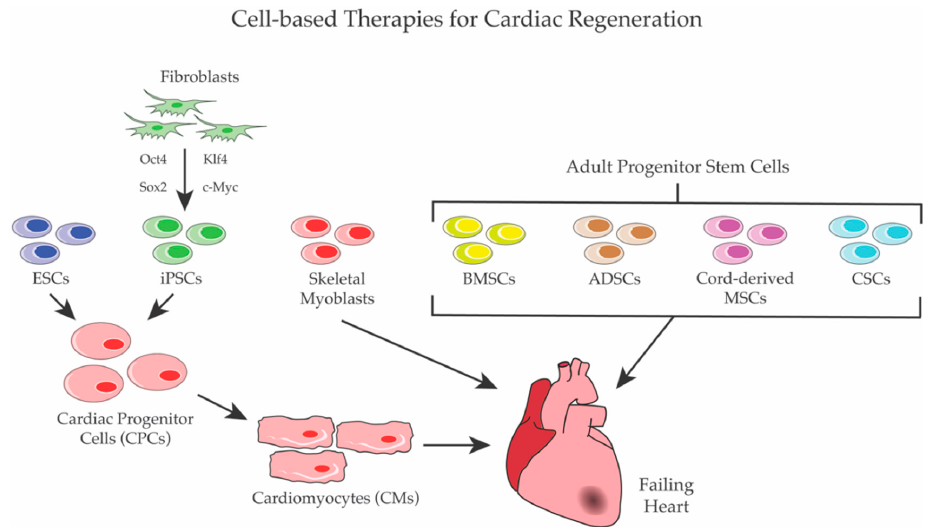
Figure 1. Cell-based Therapies for cardiac regeneration. Several populations of stem cells were used for cardiac regeneration. ESCs and iPSCs were first differentiated to CPCs and/or to CMs before transplantation, whereas skeletal myoblasts and adult stem cells—such as BMSCs, ADSCs, cord-derived MSCs, and CSCs—were directly employed to regenerate heart.